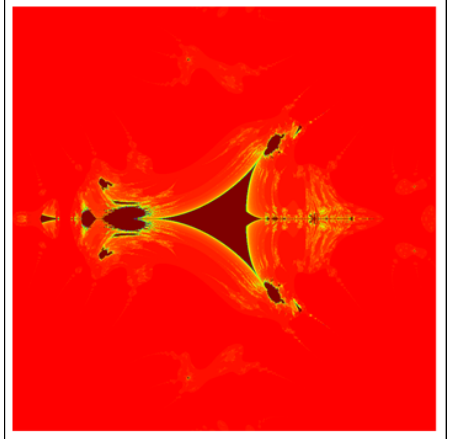
Figure 59. Tricorn via F-iteration with image visual time = 154.01 s.